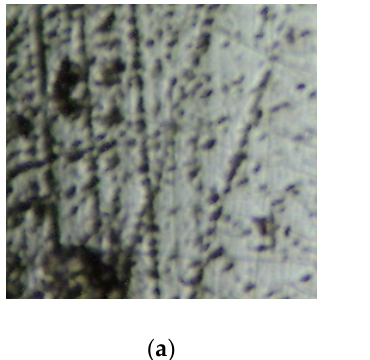
Figure 11. Profiles of pressing dies with or without ultrasonic polishing: ( a ) pressing die with sine- wave shape (without ultrasonic polishing); ( b ) pressing die with sine-wave shape (with ultrasonic polishing).